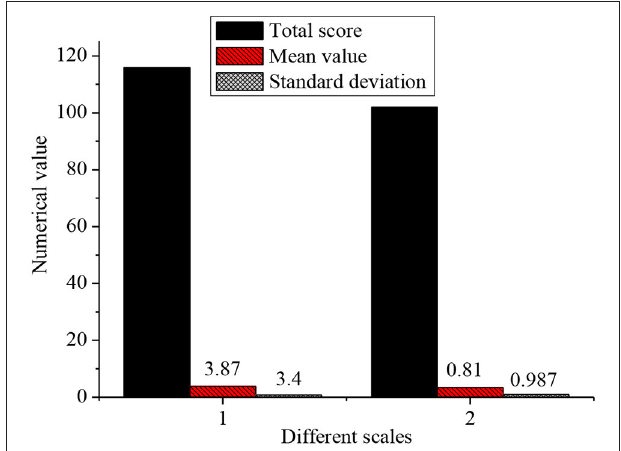
FIGURE 8 | Psychological states of new entrepreneurial talents (1. Entrepreneurial motivation; 2. Self-confidence).